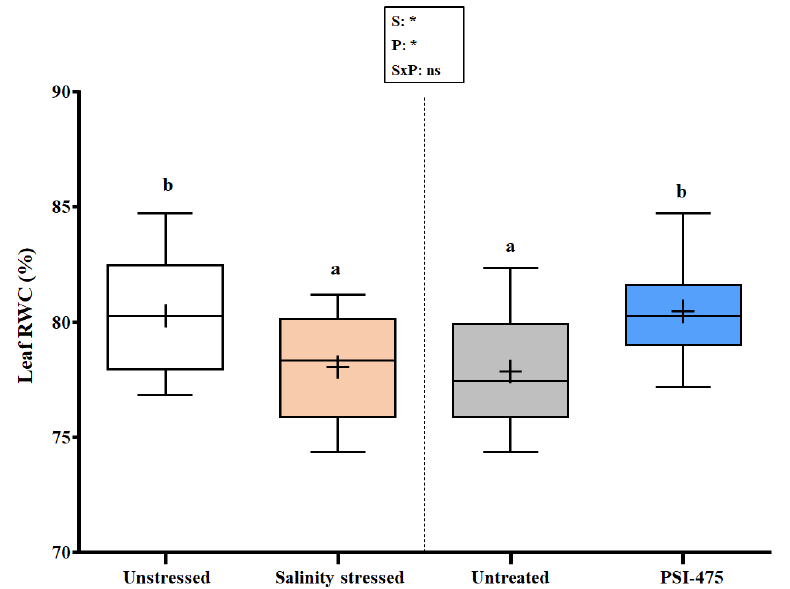
Figure 3. Effect of salinity stress and PSI-475 on tomato young leaf RWC. Since there was no signif- icant S × P interaction, the effect of condition and PSI-475 treatment was evaluated separately, comparing the respective means. Different letters indicate statistically significant differences for p ≤ 0.05 based on t -test (condition and treatment). The vertical dashed line was used to visually separate the evaluation of the effect of condition and PSI-475 treatment. The horizontal line through the box and the cross represents the median and mean value, respectively. Source of variance was included in the figure (ns, *: non-significant or significant at p ≤ 0.05, respectively).